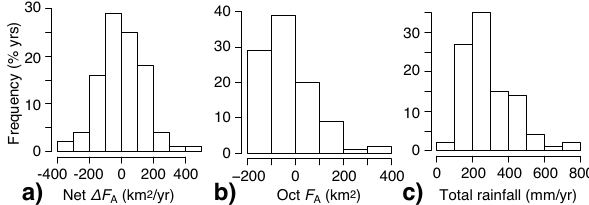
Figure 5. 1912–2012 frequency distributions of yearly (a) net change in flood area ( (cid:49)F A ), (b) end-of-the-year flood area (Oct F A ) ; km 2 ), n = 100 and (c) yearly maximum flood area ( F A max